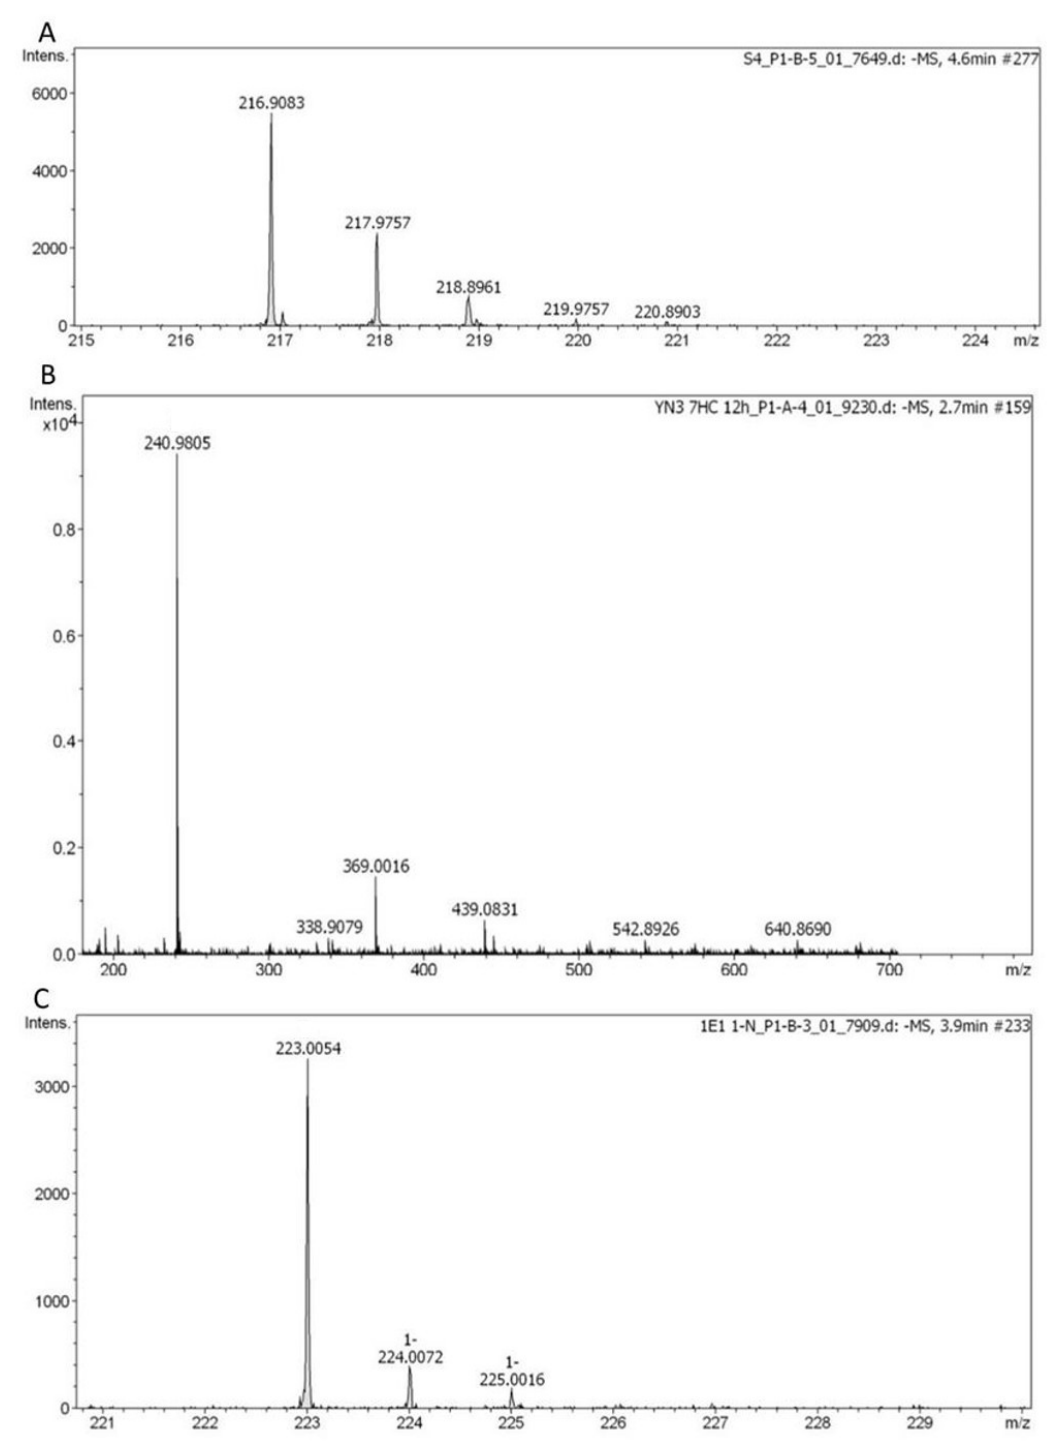
Figure 1. Exemplary results of standard SULT substrates metabolized in whole-cell biotransformations with human SULTs recombinantly expressed in fission yeast. ( A ) 4-nitrophenyl sulfate produced from 4-nitrophenol by SULT1A3 (C 6 H 5 NO 6 S, [M–H] − theor. = 217.9765, [M–H] – exp. = 217.9757, ∆ m / z = 3.67 ppm). ( B ) 7-hydroxycoumarin sulfate produced from 7-hydroxycoumarin by SULT1B1 (C 9 H 6 SO 6 , [M–H] − theor. = 240.9813, [M–H] – exp. = 240.9805, ∆ m / z = 3.32 ppm). ( C ) 1-naphthyl sulfate produced from 1-naphthol by SULT1E1 (C 10 H 8 O 4 S, [M–H] – theor. = 223.0071, [M–H] – exp. = 223.0054, ∆ m / z = 7.62 ppm).